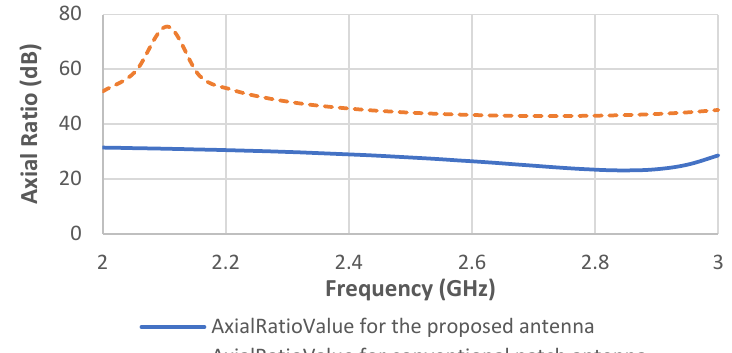
Figure 12. Axial ratios of the conventional and proposed patch antennas.